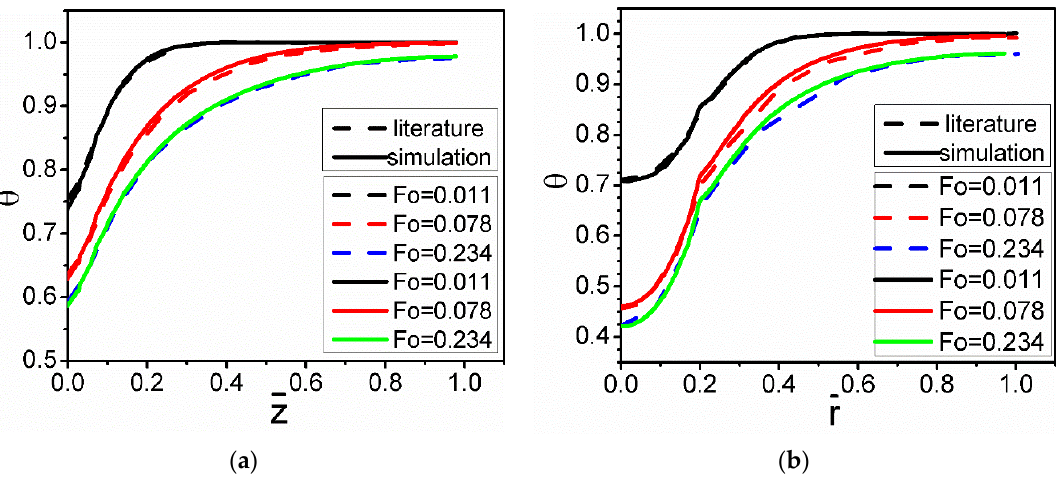
Figure 4. Comparison of the results from the present simulation with that reported in the literature [30] on the evolution of temperature without the nickel coating: ( a ) r̅ = 0.25, ( b ) z(cid:3364) = 0.1. Dimensionless heat flux as a function of radial location is studied for four axial-loca- tion cases and different time cases in Figure 5. It can be seen that the heat flux within the fiber changes little along the radial direction, but the heat flux in the melt declines sharply.